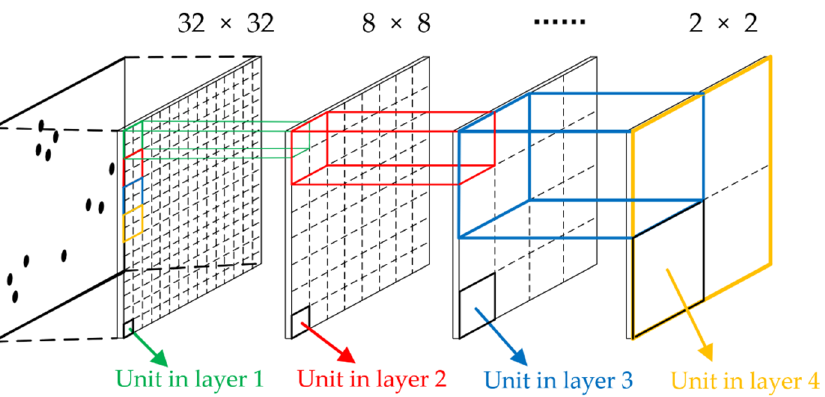
Figure 9. Structure of crowd density distribution detection based on the multi-layer fusion algo- rithm.